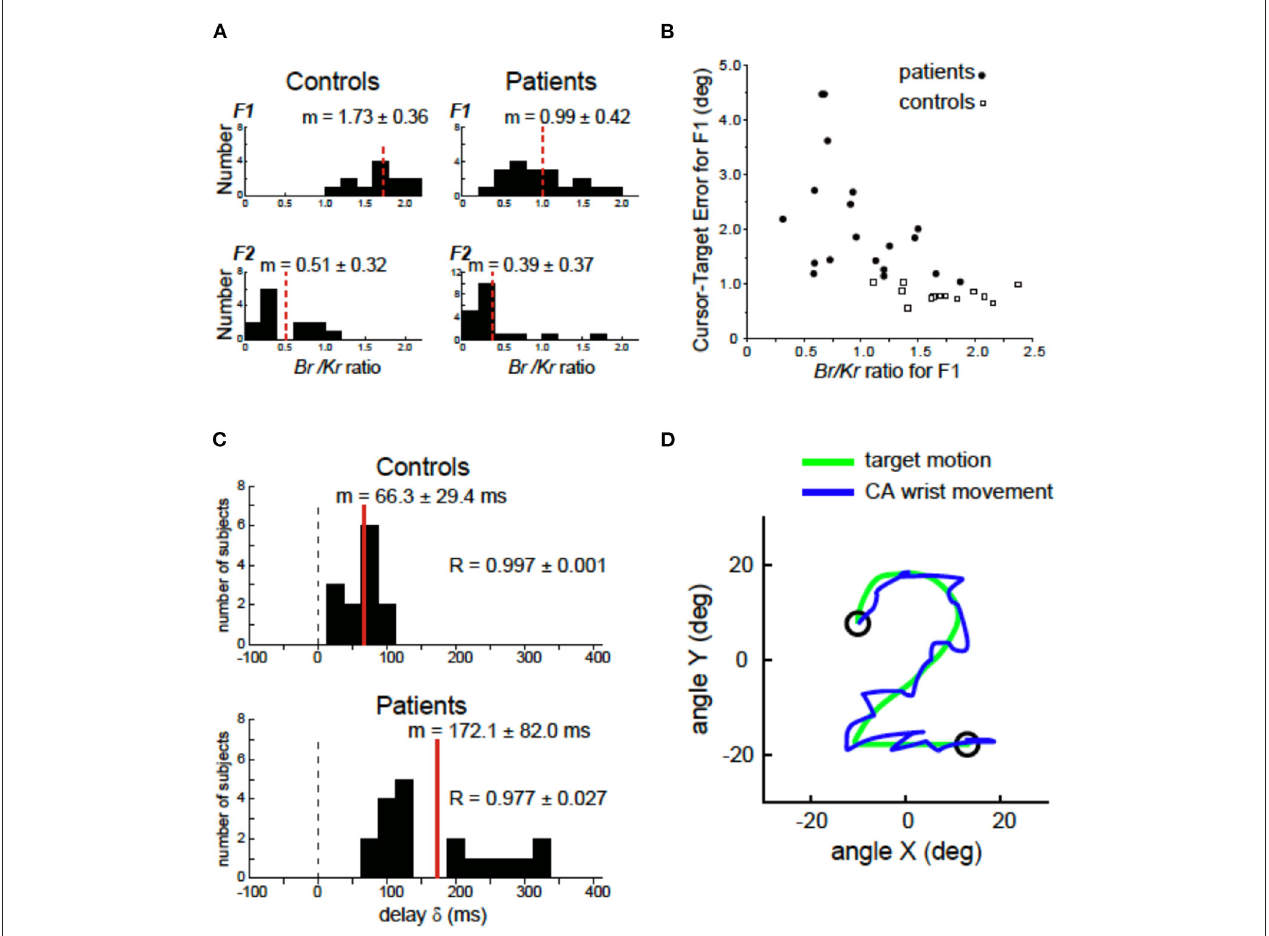
FIGURE 3 | Deficits of forward models in patients with cerebellar ataxia (CA). (A) Comparison of the Br/Kr ratios that represents recipe of the motor commands for the F1 and F2 components between the controls and the cerebellar patients. Controls: Br/Kr ratios of the control subjects for the F1 component (top) and the F2 component (bottom) ( n = 13). Note the highly significant difference between the two components. Patients: Br/Kr ratios of the patients for the F1 (top) and the F2 (bottom) components ( n = 19). Note the selective decrease in Br/Kr ratios for the F1 component in the patients. (B) Correlation between the Br/Kr ratios for F1 component and cursor–target error for F1 (F1 error, in short). The F1 error is defined as an average error between the target motion and the F1 component of the movement. Note the negative correlation. (C) Delay of the predictive (F1) component of the movement relative to the target motion calculated with a cross-correlation analysis for controls ( n = 13) and patients ( n = 19). (D) A highly ataxic wrist movement of a CA patient. Note the irregular tremor-like movement trajectory. Adapted from Kakei et al. ( 69) under CC-BY